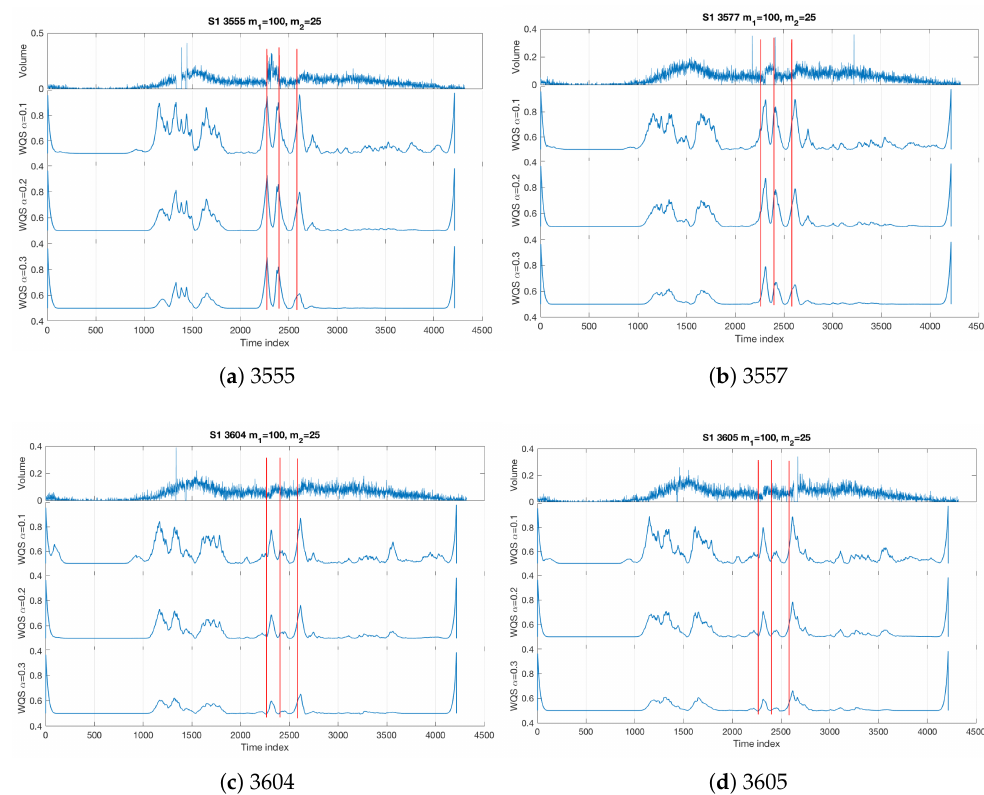
Figure 5. Incident S1 single sensor analysis. The weighting parameters are m 1 = 100, m 2 = 25 over different recurrence plot threshold scales α = 0.1,0.2, 0.3. The vertical red lines refer to the incident start time, incident end time, and queue end time, respectively (see Table